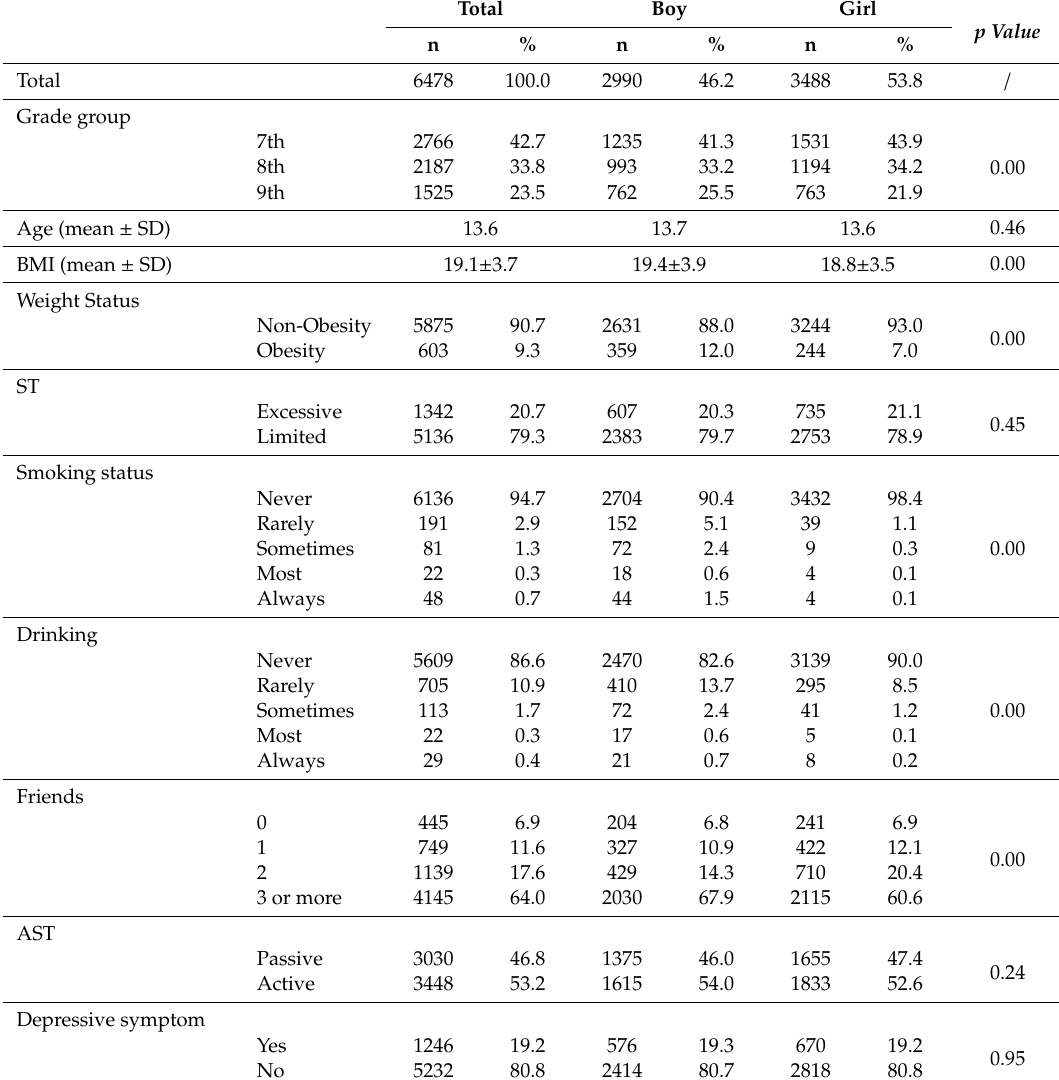
Table 1. Characteristics of Samples in this